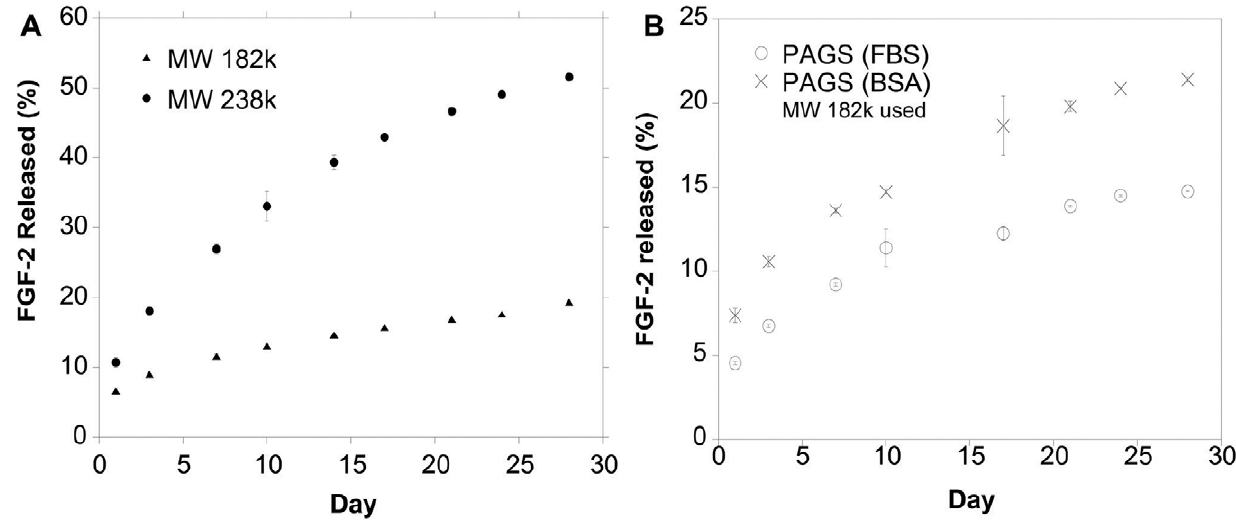
Figure 4. Release kinetics of FGF-2 in PBS and in the presence of serum proteins. [A] Release kinetics as examined by measuring the amount of 125 I-FGF-2 released from complexes. The percent of FGF-2 released from complexes was monitored over 28 days. Two different molecular weight species of PAGS were used to characterize whether release kinetics were controllable. The LMW species of PAGS released nearly 20% of its loaded growth factor, while the HMW species of PAGS released approximately 50% of incorporated growth factor over the same period of time. [B] The addition of BSA had minor impact on the release FGF-2, which is consistent with the low affinity of BSA with heparin. On the other hand, negatively charged serum proteins in FBS formed precipitate surrounding the delivery matrix, which decreased the FGF-2 release rate.